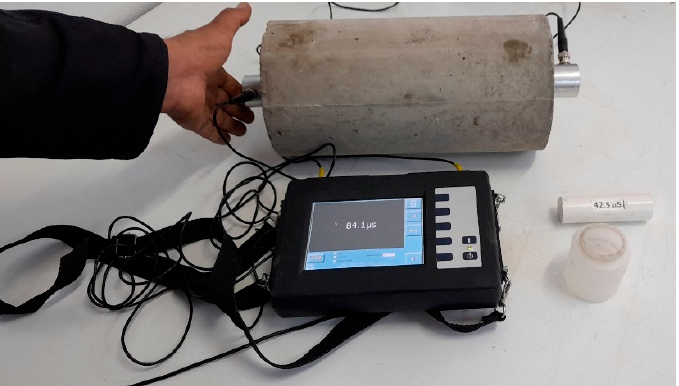
Figure 8. Ultrasonic pulse velocity test.